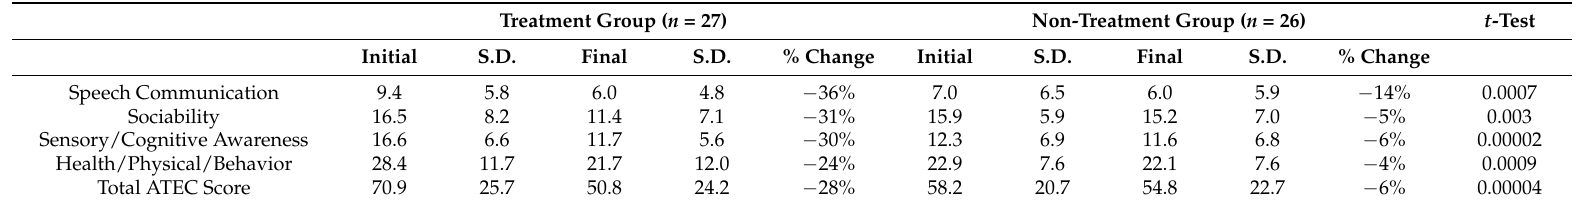
Table 7. Autism Treatment Evaluation Checklist